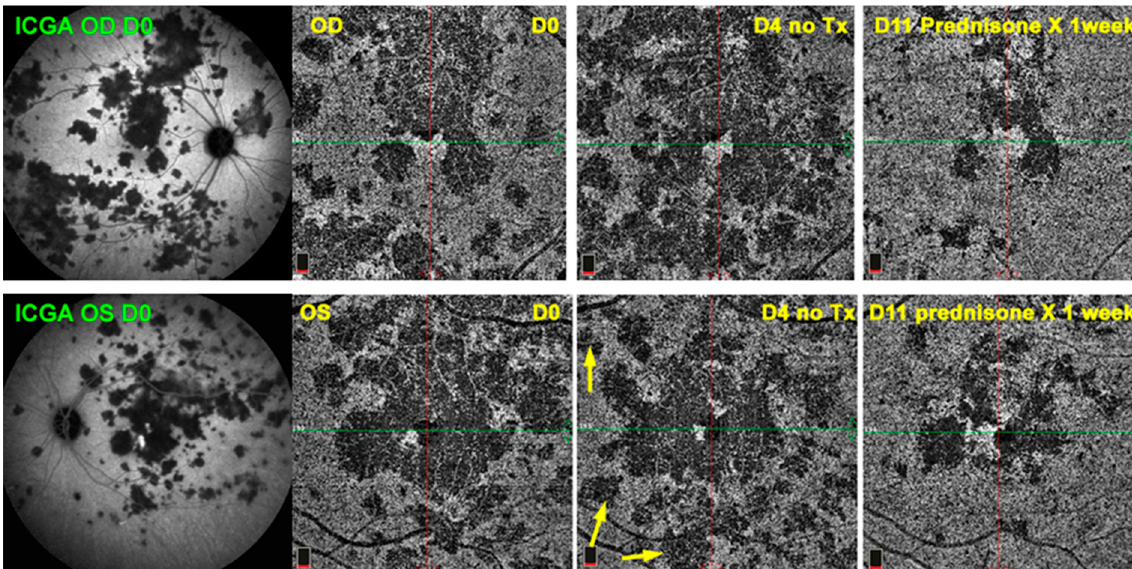
Figure 3. OCT-A follow-up of APMPPE. Example of practical usefulness of OCT-A in a patient with APMPPE (same patient as Figure 1). At presentation, ICGA frames clearly establish the global involvement of the fundus. To monitor the evolution of lesions and the impact of therapy, OCT-A allowed a close follow-up, although only of the central lesions (6 frames to the right). Yellow arrows show new areas of drop-out before regression of lesions following introduction of corticosteroids (frames at the extreme right).